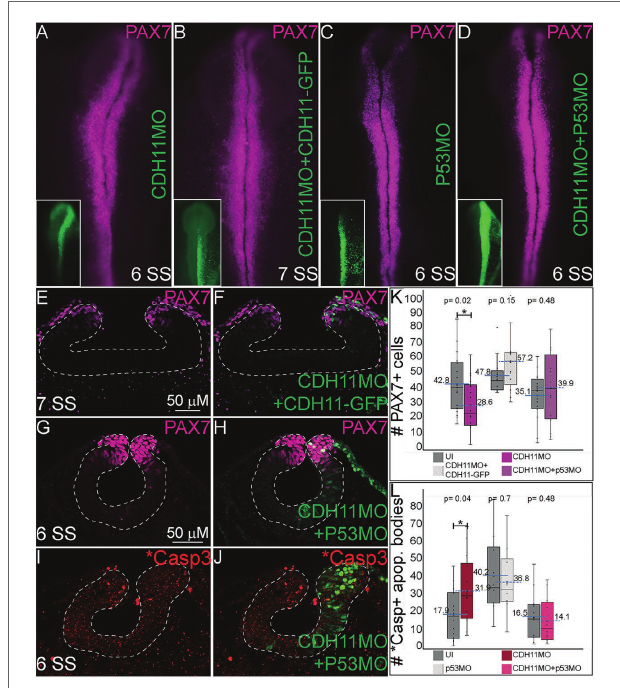
FIGURE 5 | Blocking p53-mediated apoptosis rescues the NC fate. To determine if the NC and *Casp3 phenotypes resulted from p53-mediated apoptosis, embryos were injected with multiple combinations of treatments to attempt to rescue the phenotype. (A–D) Whole mount IHC for PAX7 in HH8- HH9 embryos after (A) CDH11MO, (B) CDH11MO + CDH11-GFP, (C) p53MO, or (D) CDH11MO + p53MO. Inset shows treatment injection (green). (E) IHC for PAX7 in transverse section from HH9 embryo with (F) overlay with CDH11MO + CDH11-GFP (green). (G) IHC for PAX7 in transverse section from HH9 embryo with (H) overlay with CDH11MO + p53MO (green). (I) IHC for *Casp3 in transverse section from HH8 embryo with (J) overlay with CDH11MO + p53MO (green). (K) Graph showing difference in PAX7 expression between uninjected and injected sides. Mean number of PAX7+ cells is 42.8 on uninjected and 28.6 on CDH11MO- injected side, p = 0.02, n = 18. Mean number of PAX7+ cells is 47.77 on uninjected and 57.23 on CDH11MO + CDH11-GFP-injected side, p = 0.15, n = 13. Mean number of PAX7+ cells is 35.06 on uninjected and 39.94 on CDH11MO + p53MO-injected side, p = 0.48, n = 16. (L) Graph showing difference in *Casp3 expression between uninjected and injected sides. Mean